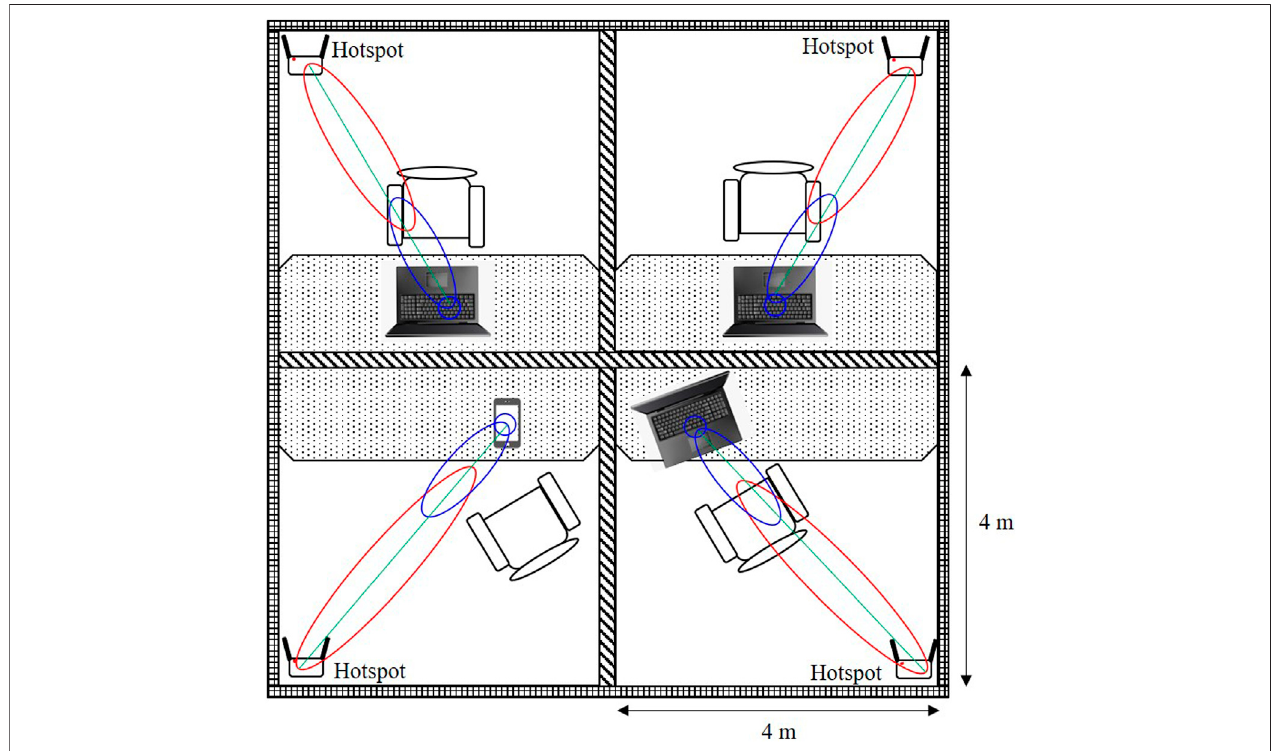
FIGURE 3 | Spatial frequency reuse of 60 GHz band in a 4-cubicle indoor of fi ce environment.